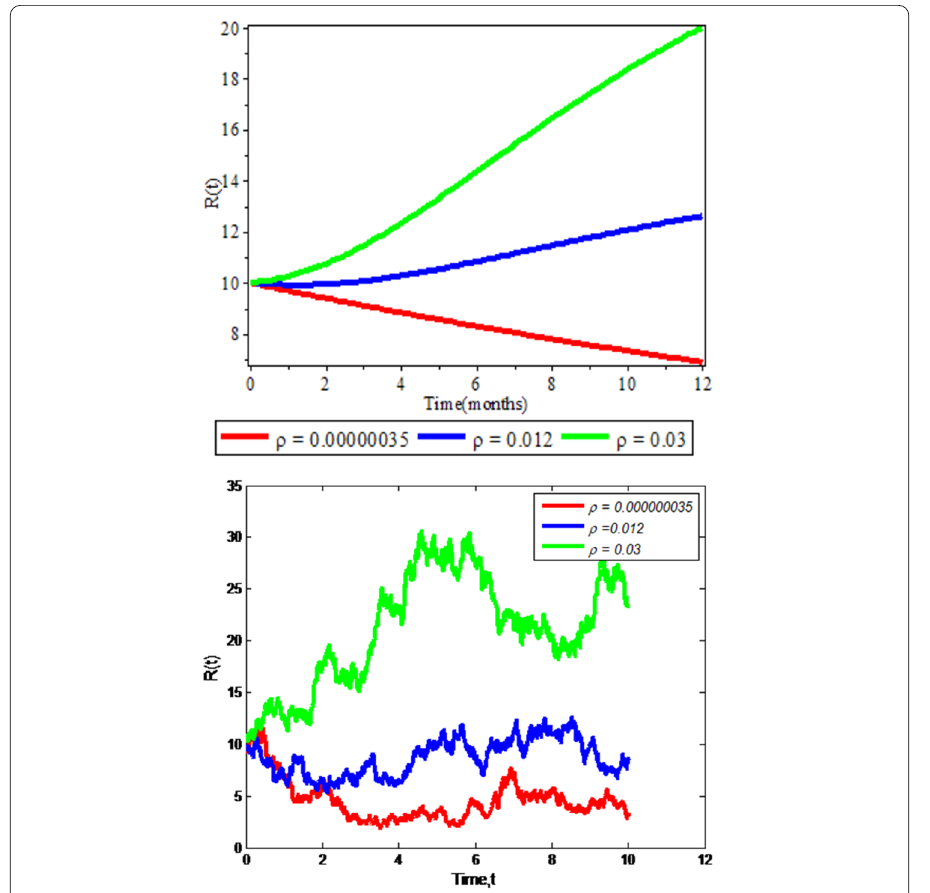
Figure 5 Effect of recovery rate on recovered individuals